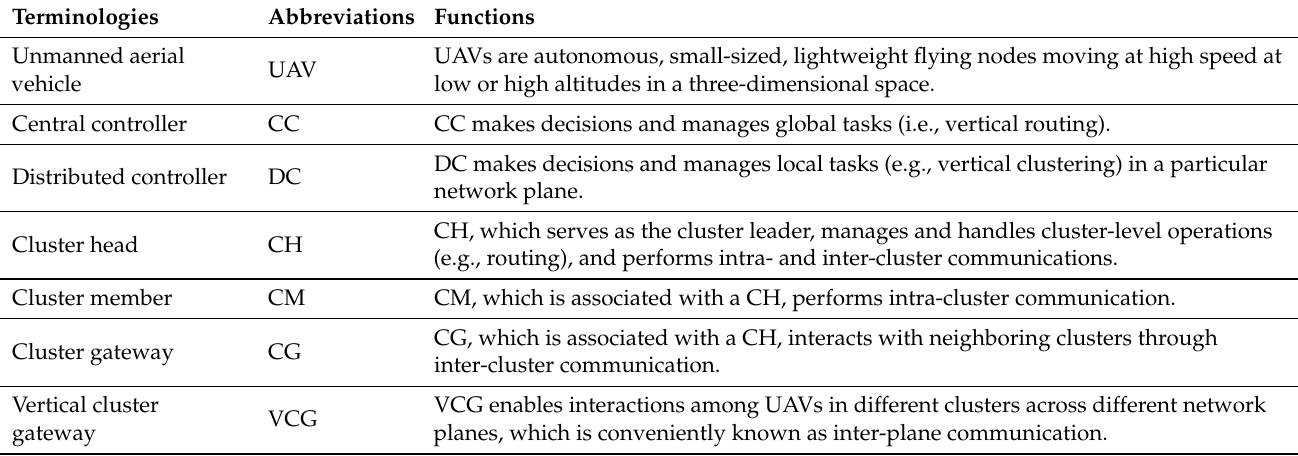
Table 3. The functions of various network entities are shown in Figure